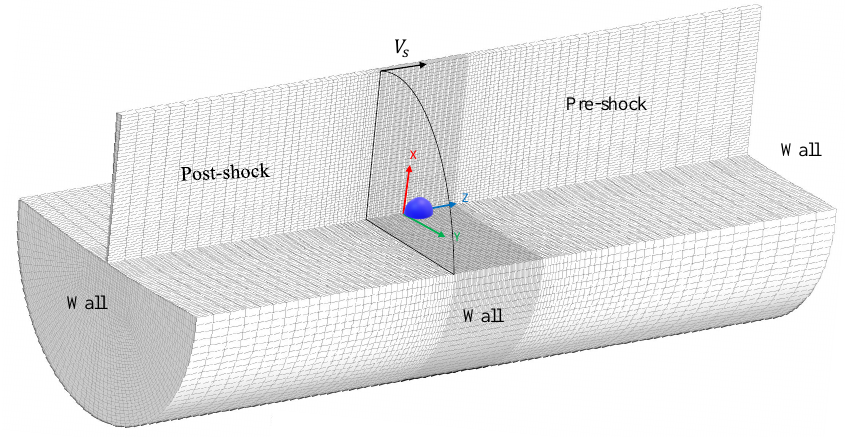
Figure 1. Sketch of spatial domain and physical model with the traveling shock